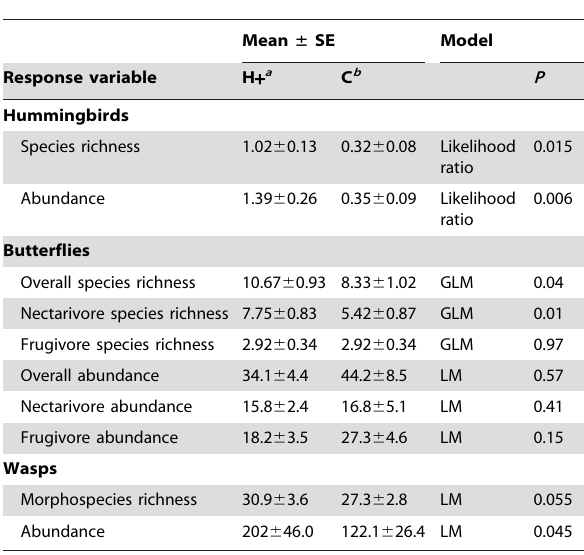
Table 3. Flower-visiting community in coffee agroforests in Costa Rica, comparing agroforests with and without experimentally planted shrubs with a steady-state flowering